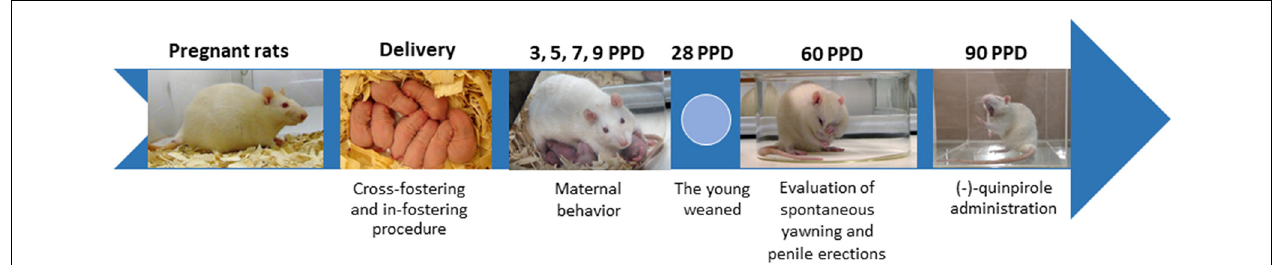
FIGURE 1 | Experimental design. Pregnant female rats from the high-yawning (HY), low-yawning (LY), and Sprague–Dawley (SD) lines were maintained in individual acrylic cages until they delivered the pups. In the first 8 h, the pups were culled to eight pups (four males and four females), and they were weaned at 28 days of age. At 60 days of age, we evaluated spontaneous yawning and penile erections in a glass cylinder, and later, the dose-response to systemic ( − )-quinpirole administration was evaluated in a novel environment. PPD, post-partum